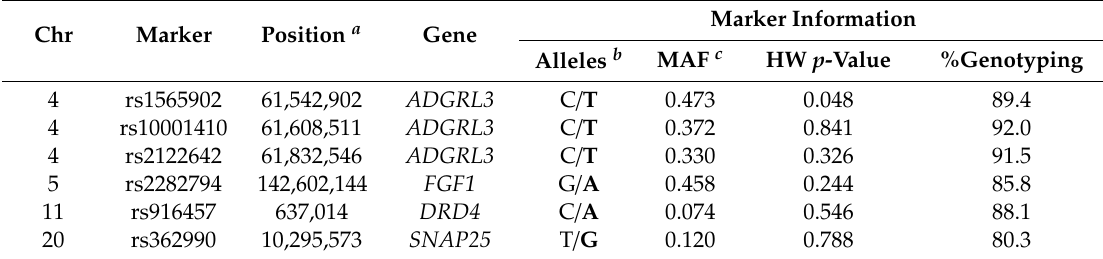
Table 2. Statistics for genotyped markers passing quality control in 386 individuals segregating ADHD and belonging to 113 nuclear families from a Caribbean community.